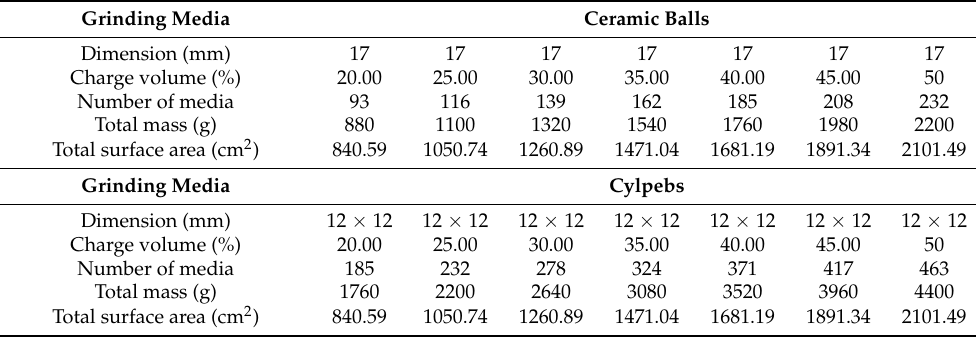
Table 8. Comparison of ceramic balls and cylpebs with different charge